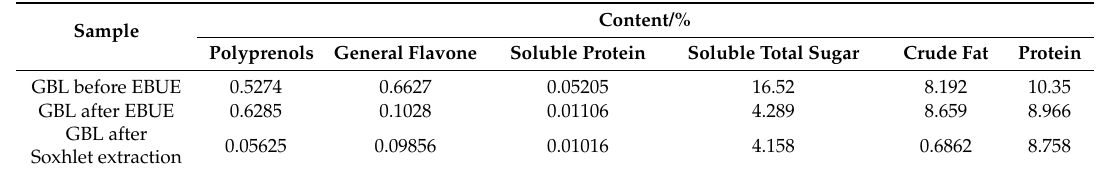
Table 1. Contents of nutrition and active ingredients in the Ginkgo biloba leaves before and after enzymolysis based ultrasound extraction (EBUE).